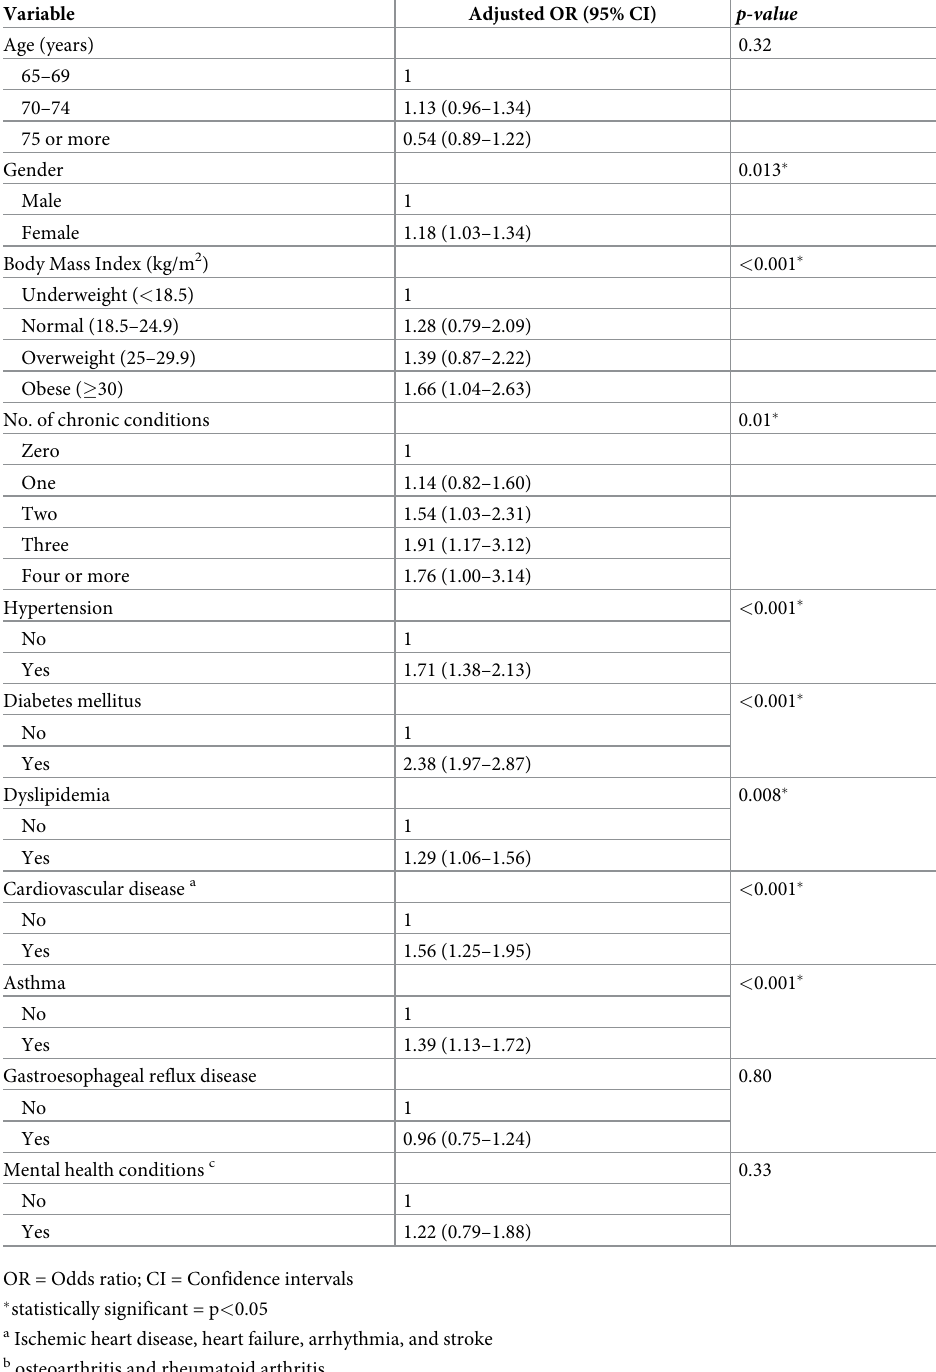
Table 5. Multivariate logistic regression analysis of predictors of